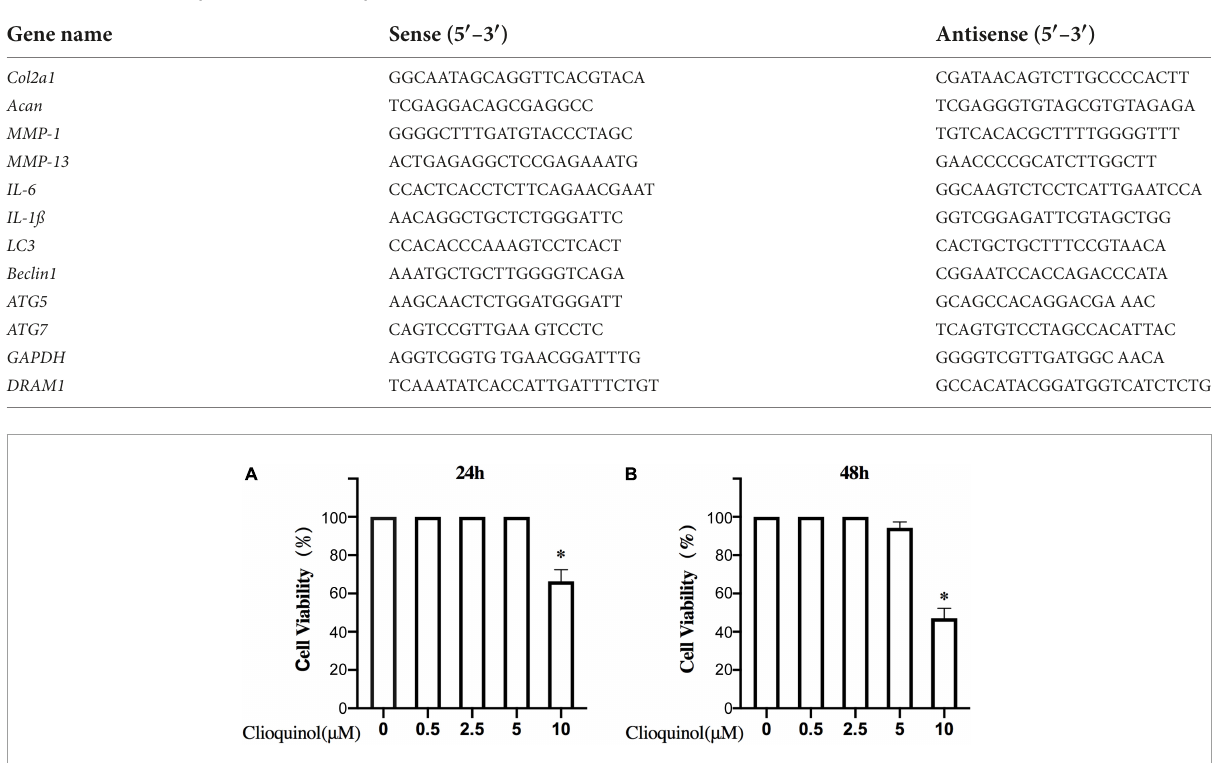
TABLE 2 Details of the primers used in RT-qPCR.